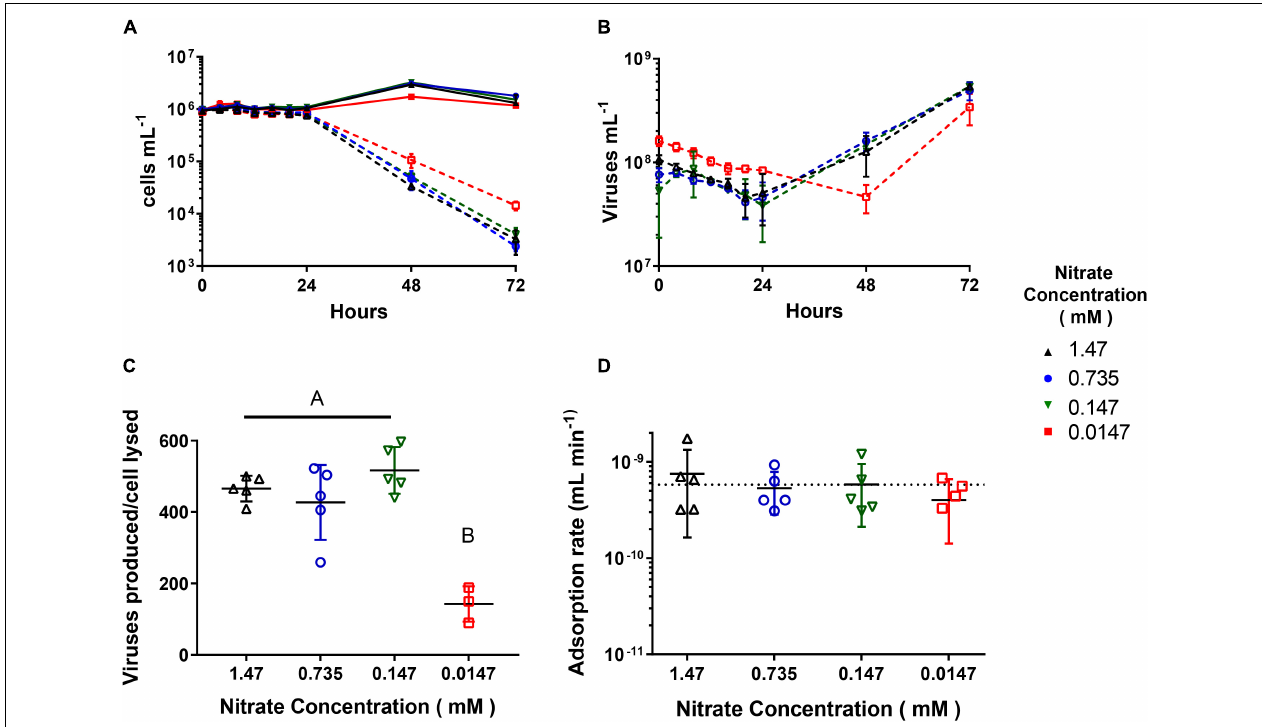
FIGURE 2 | AaV infection cycle dynamics of Aureococcus anophagefferens acclimated to decreasing NO − 3 concentrations. (A) A. anophagefferens and (B) AaV concentrations over the 3-day experiment. (C) AaV produced per host cell lysed. (D) Adsorption rates of AaV as calculated as previously reported (Cottrell and Suttle, 1995). The dotted line represents the adsorption rate ( − 5.8 × 10 − 10 mL min − 1 ) previously reported for AaV (Brown and Bidle, 2014). The different nitrate conditions are represented by the following colors and symbols: 1.47 mM – black upward triangles, 0.735 mM – blue circles, 0.147 mM – green downward triangles, and 0.0147 mM – red squares. Filled in symbols with solid connecting lines represent uninfected controls while open symbols with dashed lines represent infected cultures. Letters indicate that the two values being compared are not significant ( p > 0.05). Tables with significance values are Supplementary Tables 4 and 5 for data for Figures C and D , respectively. Points are for n = 5 biological replicates ±